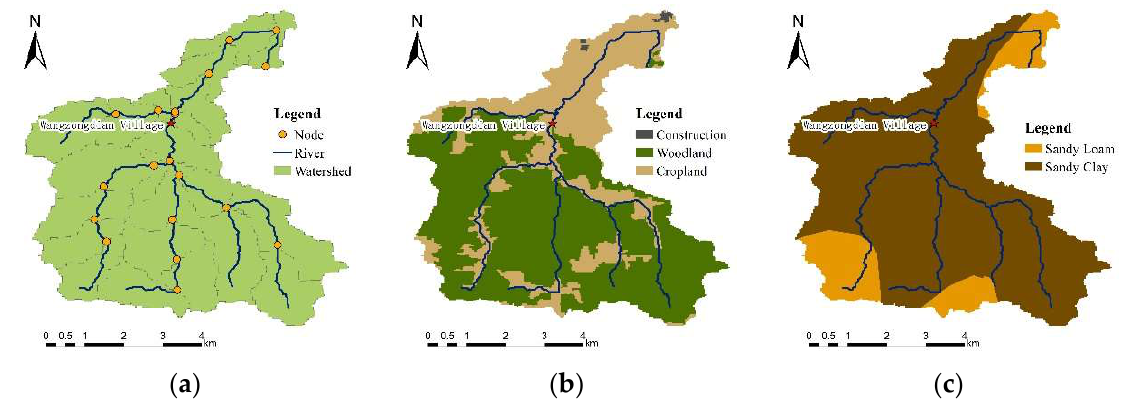
Figure 3. ( a ) Calculation unit division. ( b ) land use attribute data. ( c ) soil texture data.